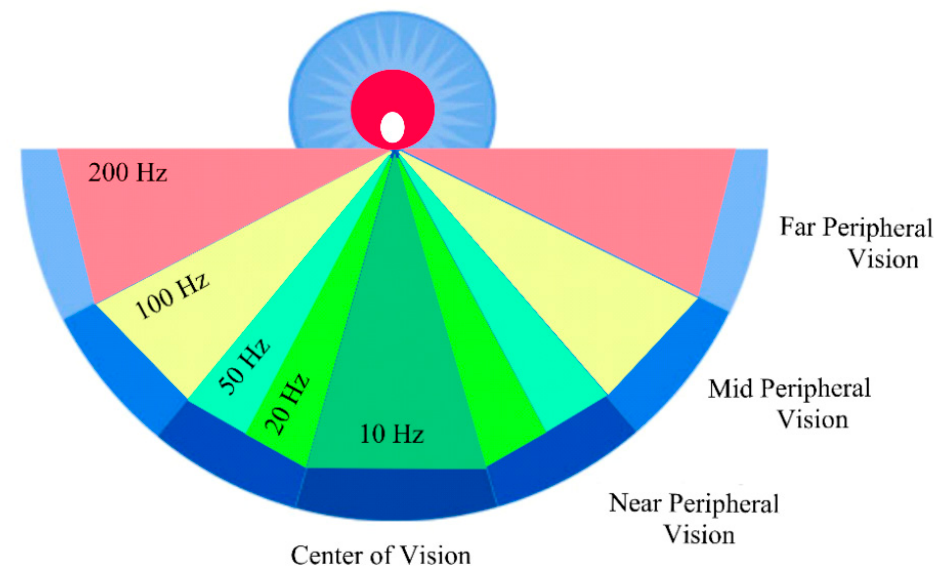
Figure 9. The basic concept of bioinspired series resonant frequency tracking.